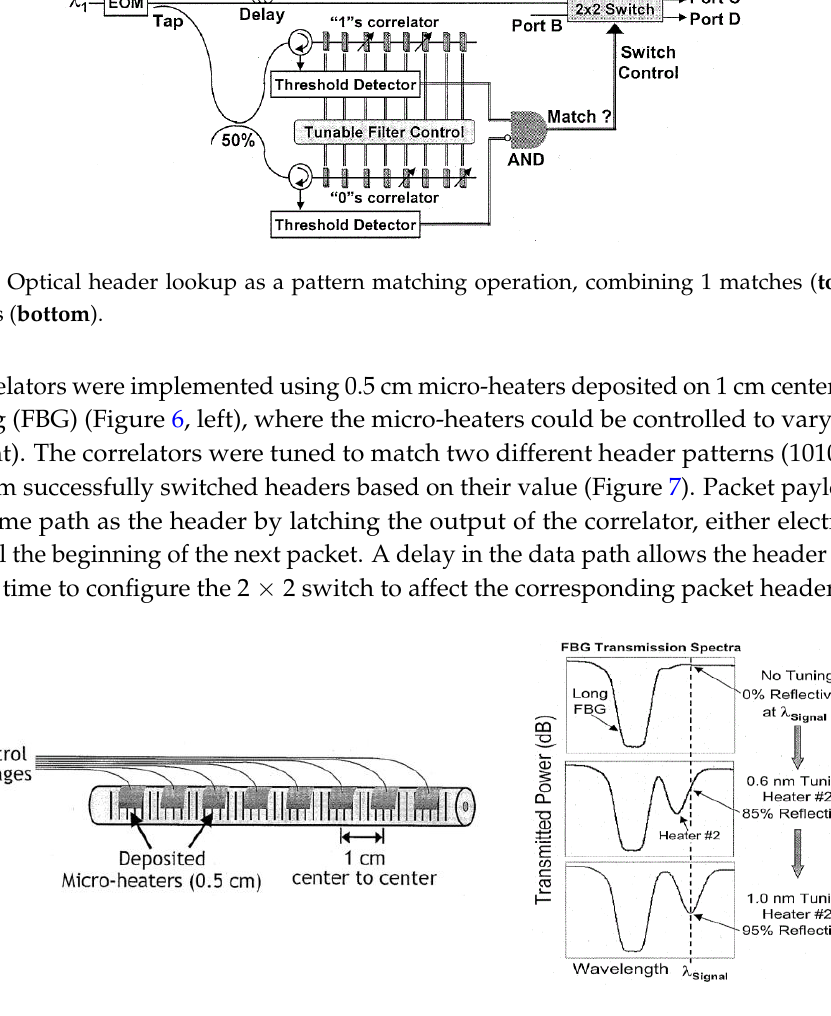
Figure 6. Correlator implemented as a sequence of micro-heaters ( left ); heater tuning impact on transmitted power ( right ).